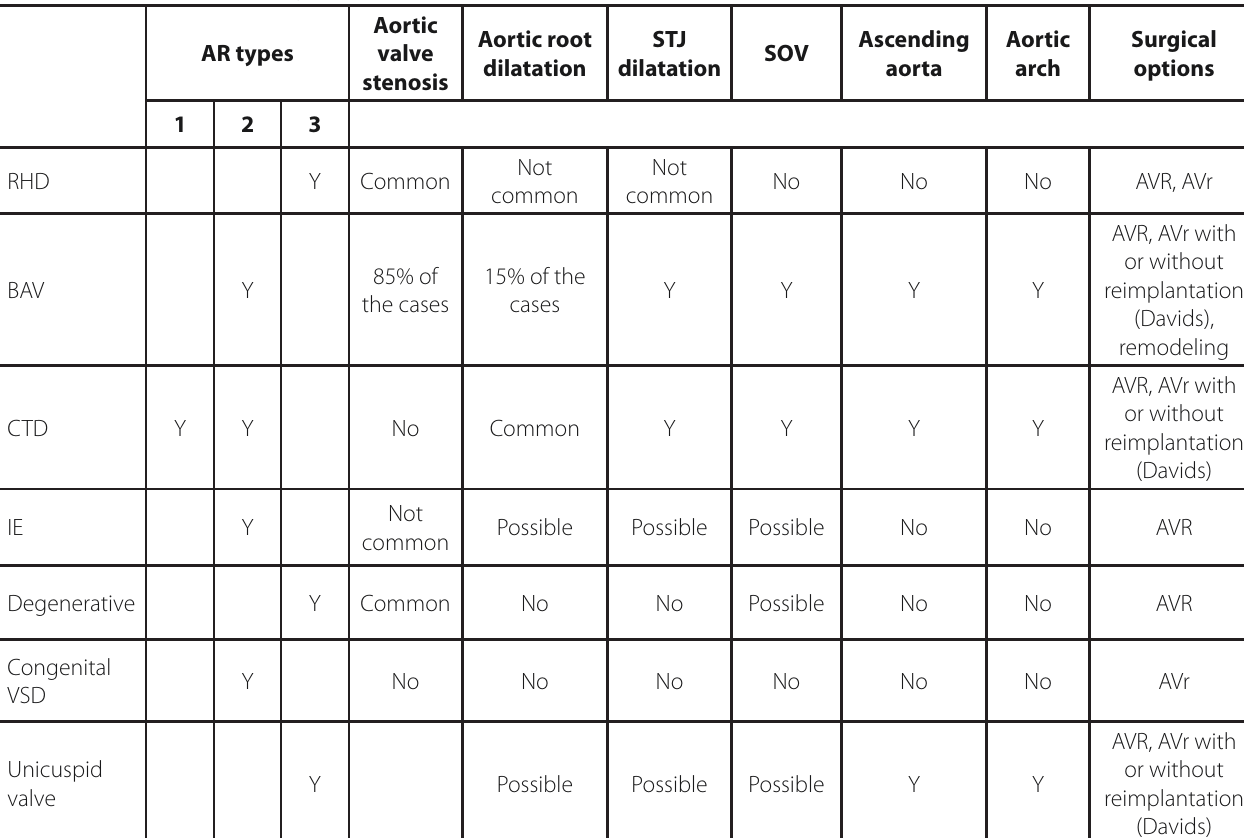
Table 1 . Management pathways.